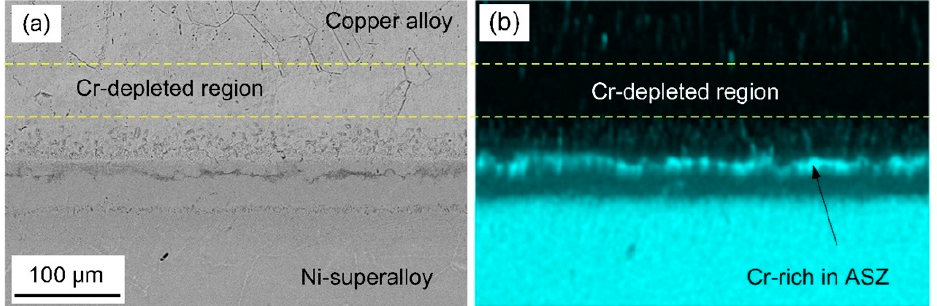
Figure 5. SEM-BSE image of the joint interface ( a ) and EDS elemental map of Cr ( b ). The ASZ is enriched in Cr whereas Cr-depleted region is formed in the DAZ of copper.